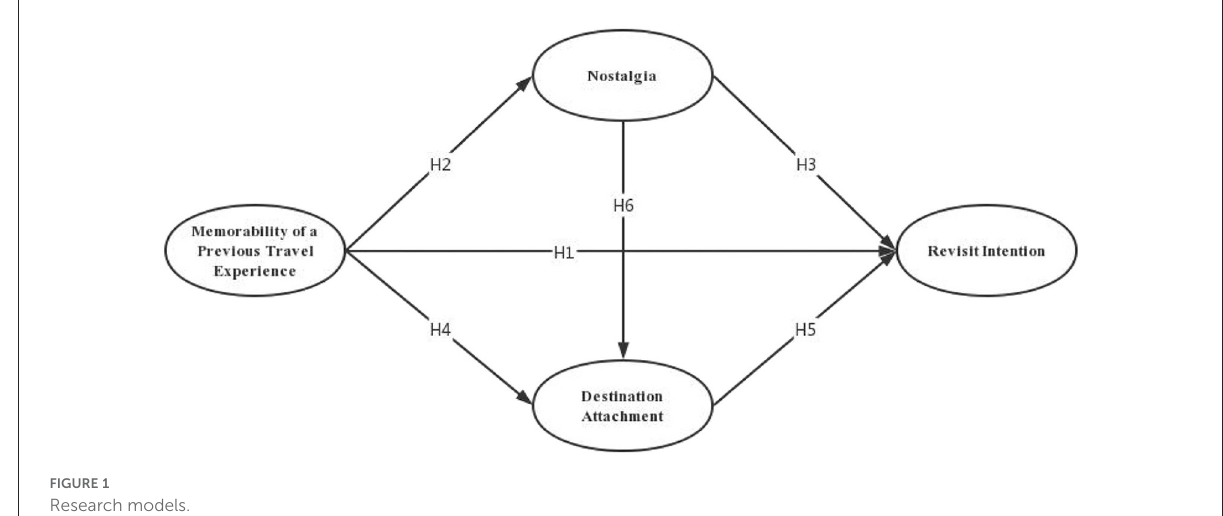
FIGURE1 Research